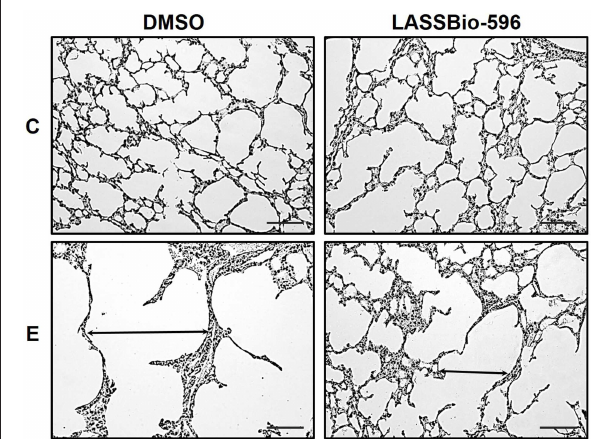
FIGURE 4 | Representative photomicrographs of lung parenchyma stained with hematoxylin-eosin. Note the enlargement of alveolar space in the E-DMSO group (arrow). C-DMSO: mice received intratracheal saline and were treated with DMSO. C-LASSBio-596 mice received intratracheal saline and were treated with LASSBio-596. E-DMSO mice received intratracheal porcine pancreatic elastase and were treated with DMSO. E-LASSBio-596: mice received intratracheal porcine pancreatic elastase and were treated with LASSBio-596. Original magnification: × 200. Bars = 100 µ m.